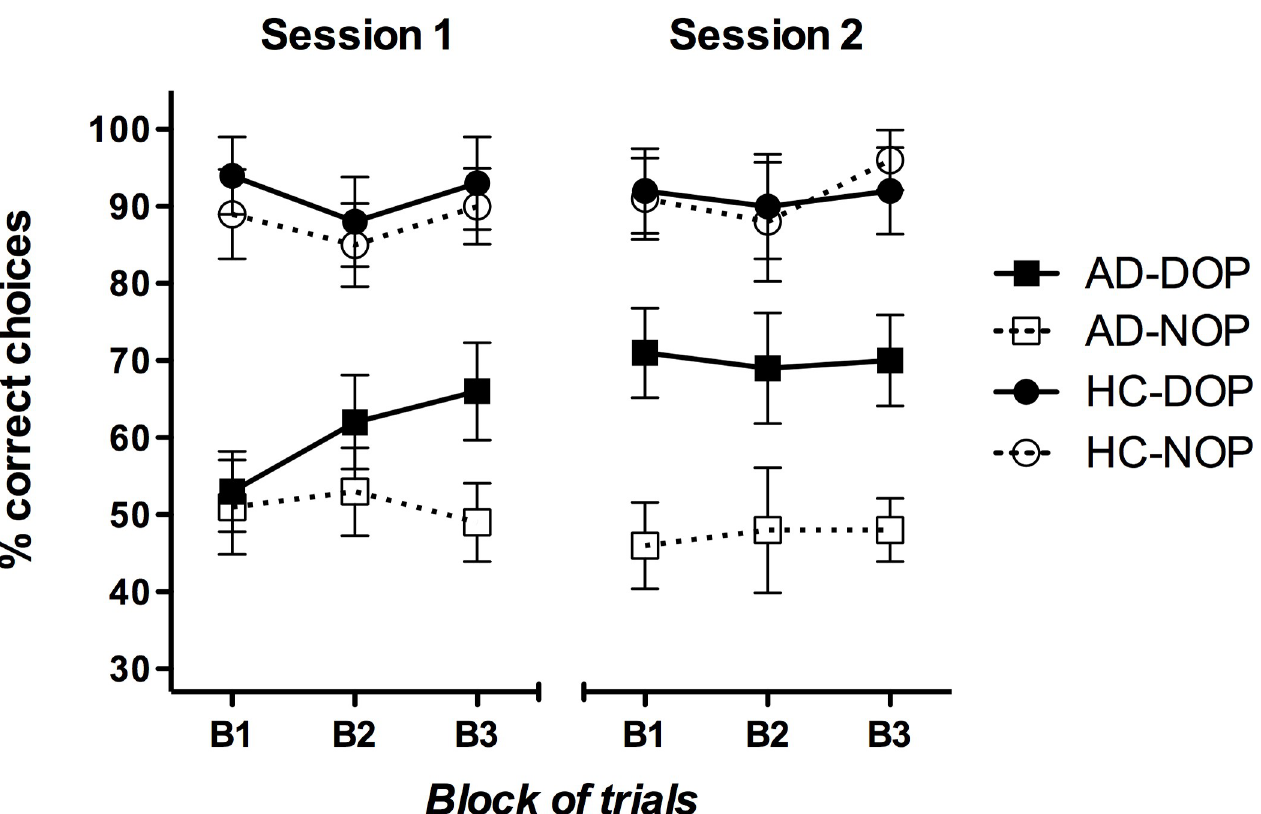
Fig 3. Mean percentages of correct responses obtained by participants in the discriminative leaning task as a function of the training session (1 and 2), blocks of trials (three blocks of 12 trials each), outcomes (DOP and NOP) and group (patients with Alzheimer’s disease–AD- and healthy controls–HC- ). Error bars show the standard error of the